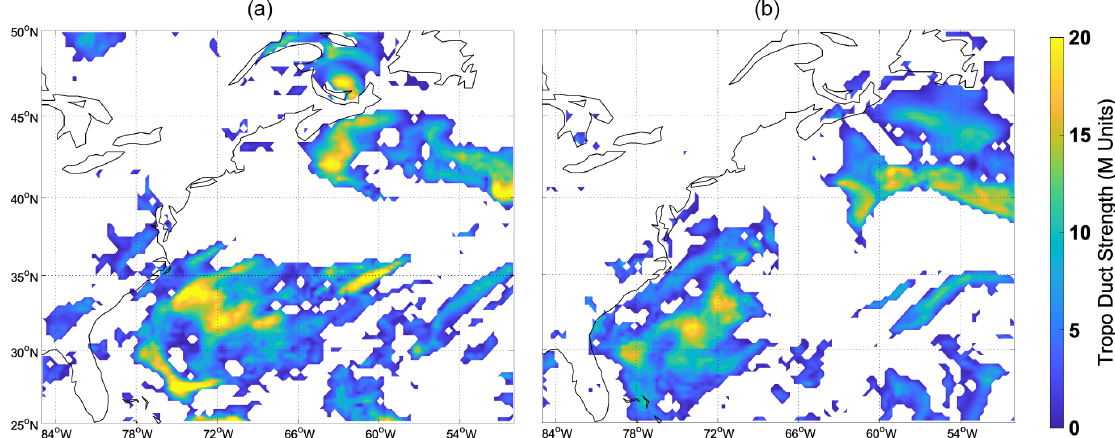
Figure 4. Figure 4 shows tropospheric ducting maps of modified refractivity (in M units) based on temperatures, pressures, and humidities in ERA5 reanalysis data. Panel (a) shows 19:00UT on 14 July 2021, while panel (b) shows 14:00UT on 13 July 2021.